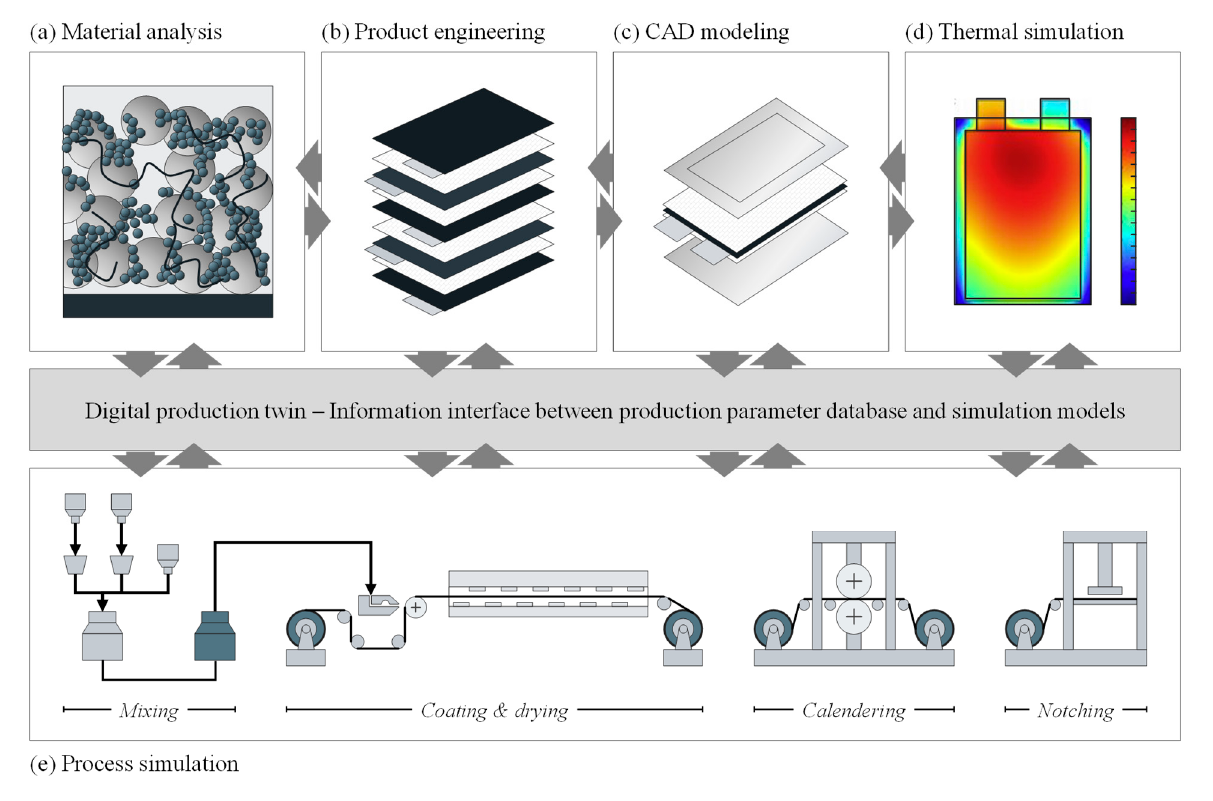
Figure 9. Interfaces and application fi elds for the digital twin.